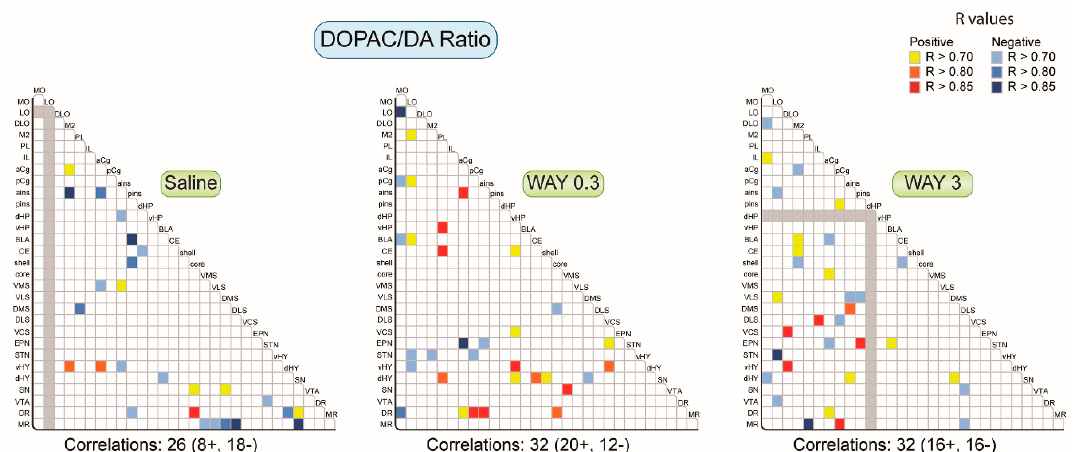
Figure 3. Correlative analysis of neurochemical indexes of DA turnover (DOPAC / DA ratio) across rat brain regions. Representation of the range of Pearson’s r values for each linear regression, DOPAC / DA ratio between the 29 brain areas in saline, WAY-163909 0.3 mg / kg, and 3 mg / kg treated rats. Colored boxes correspond to the existence of a significant correlation between the two parameters (yellow to red: positive; blue: negative) considered after correction for multiple comparisons. The grey boxes indicate that these correlations were not performed due to the low number of values (see Table S1).